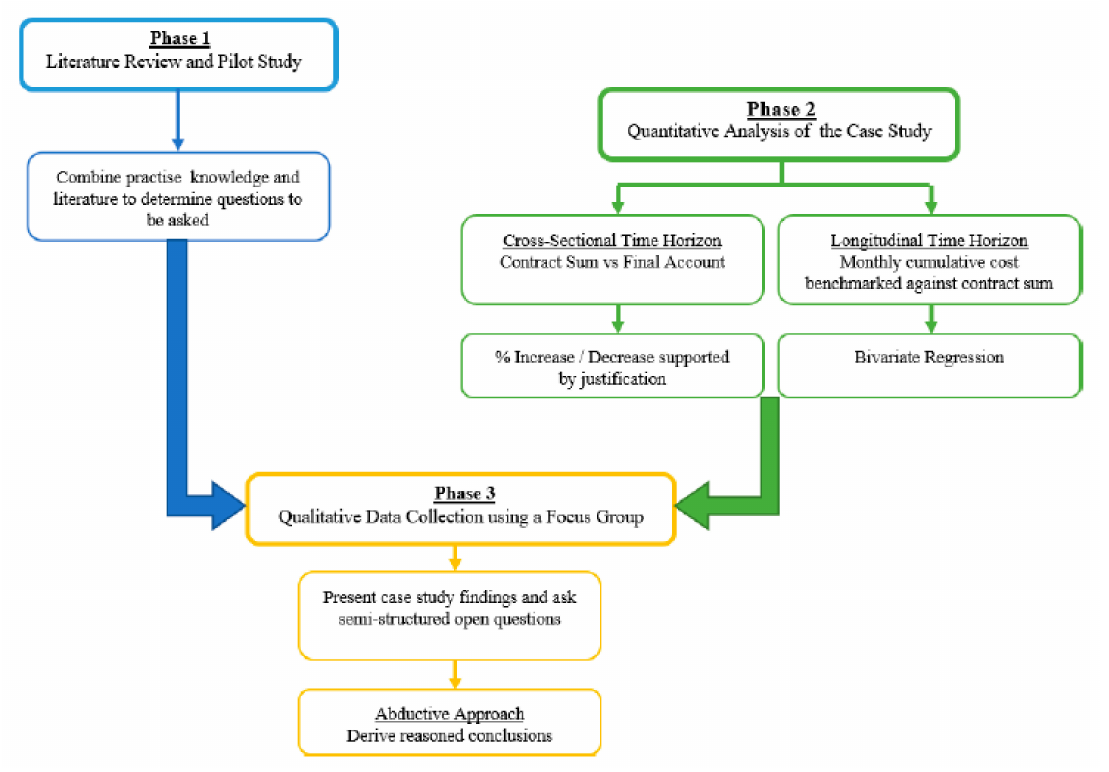
Figure 5. Waterfall research methodology. Table 2. Demographic profiles of focus group